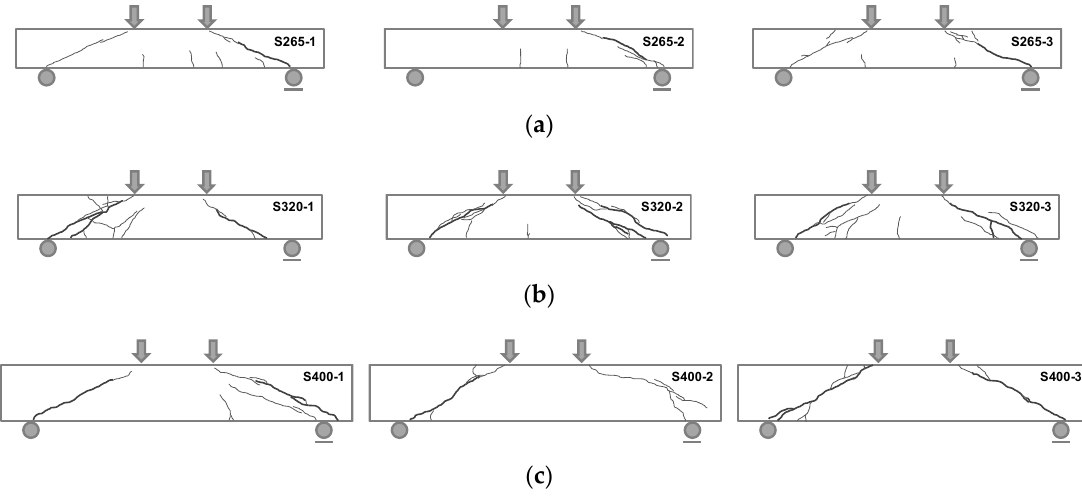
Figure 9. Crack patterns of S series at peak load: ( a ) S265; ( b ) S320; ( c ) S400.